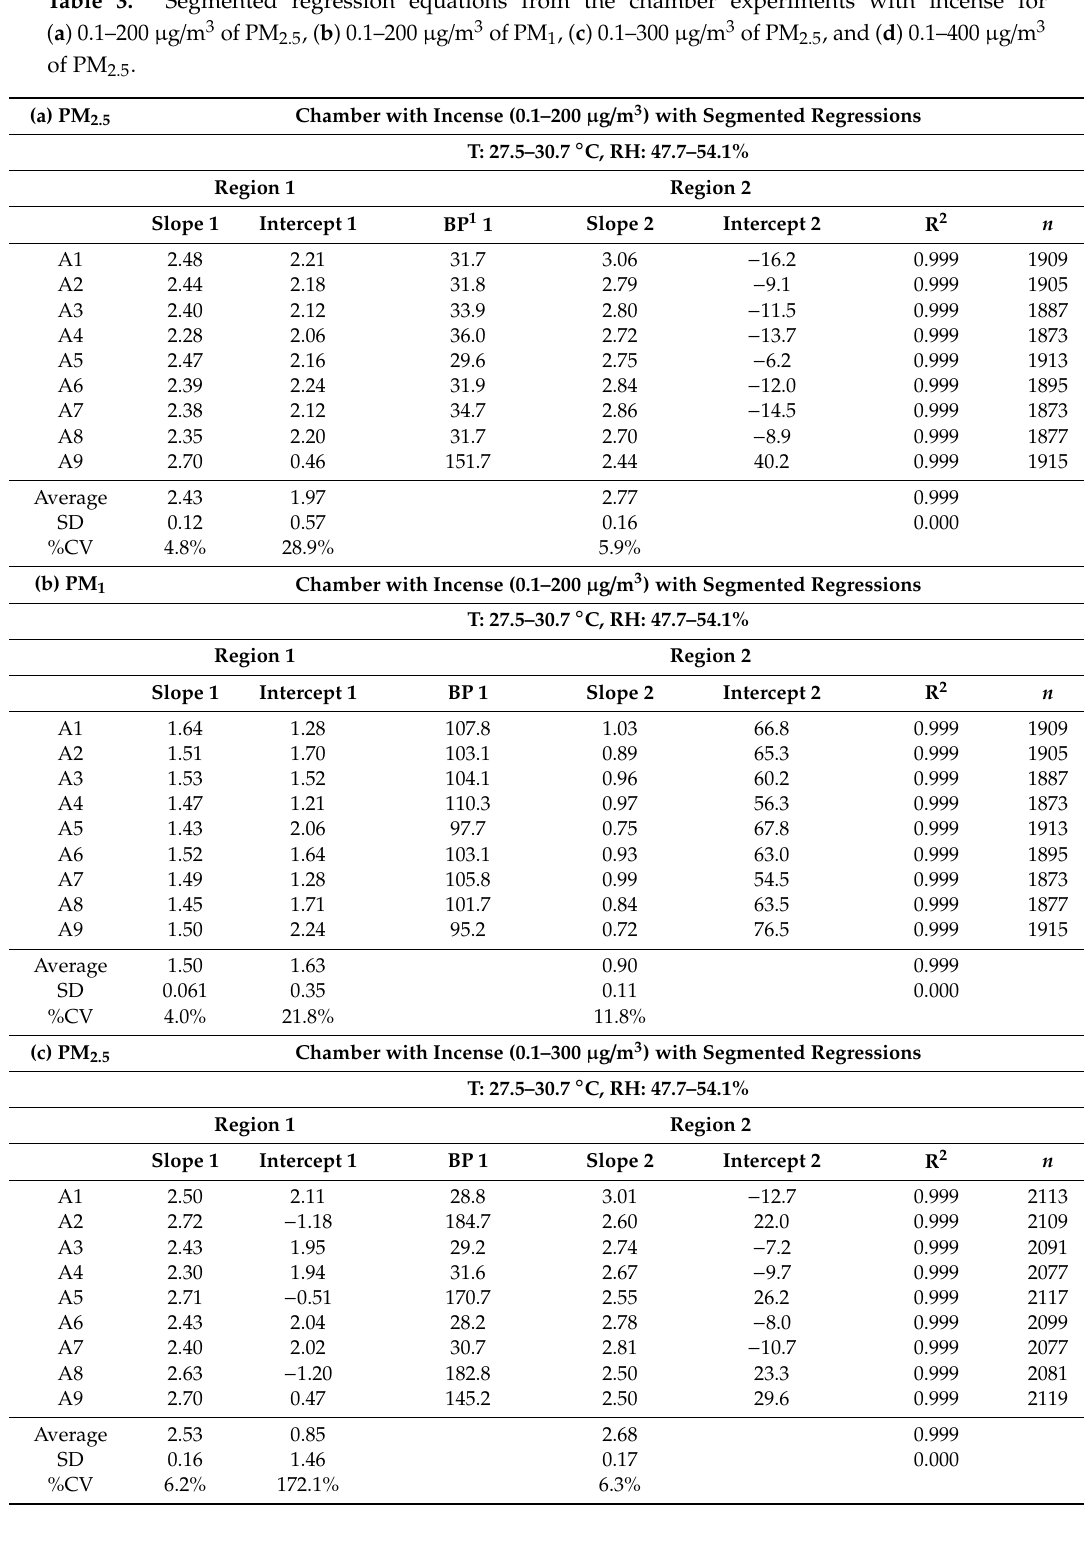
Segmented regression equations from the chamber experiments with incense for ( a ) 0.1–200 µ g / m 3 of PM 2.5 , ( b ) 0.1–200 µ g / m 3 of PM 1 , ( c ) 0.1–300 µ g / m 3 of PM 2.5 , and ( d ) 0.1–400 µ g / m